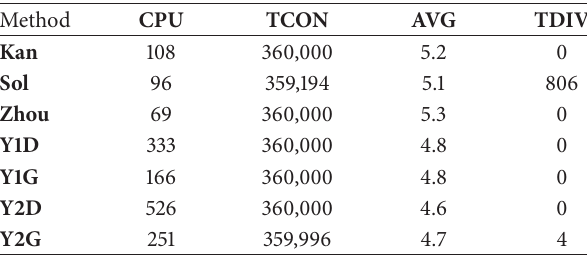
Table 7: Typical Example 4 with 𝑃 4 (𝑧) = (𝑧 2 − 1) 7 , 𝑚 = 7